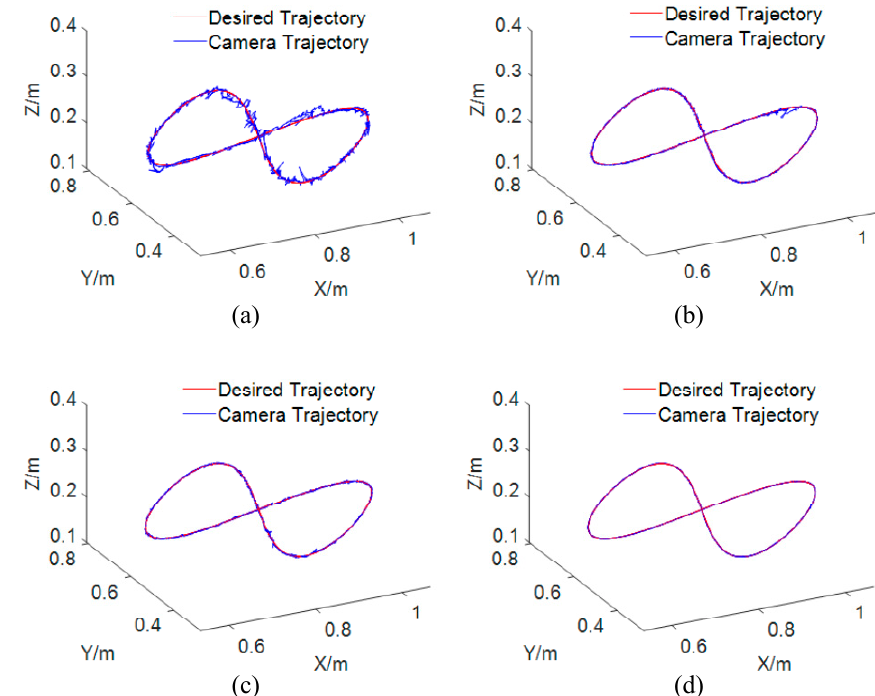
Figure 8. Camera trajectories of different strategies in a double leaf rose path. ( a ) Camera trajectory of IBUVS. ( b ) Camera trajectory of the original PHUVS. ( c ) Camera trajectory of the improved PHUVS with the KF method. ( d ) Camera trajectory of the improved PHUVS with the KF-SVSF method.